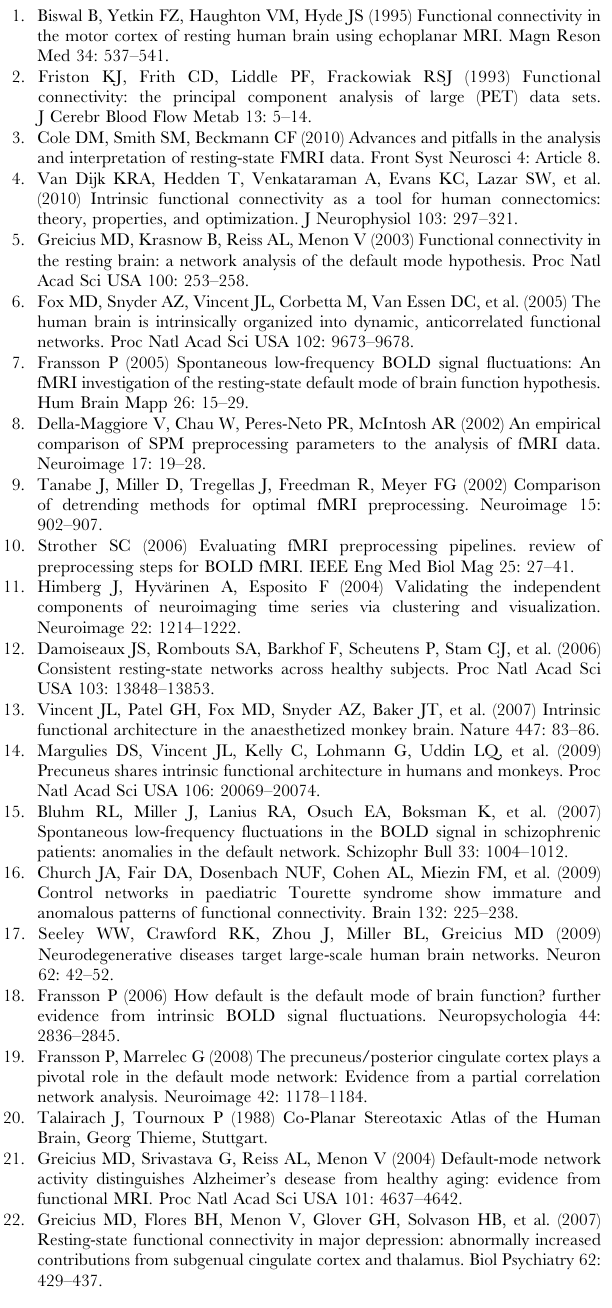
method after MDS on the data corresponding to that method